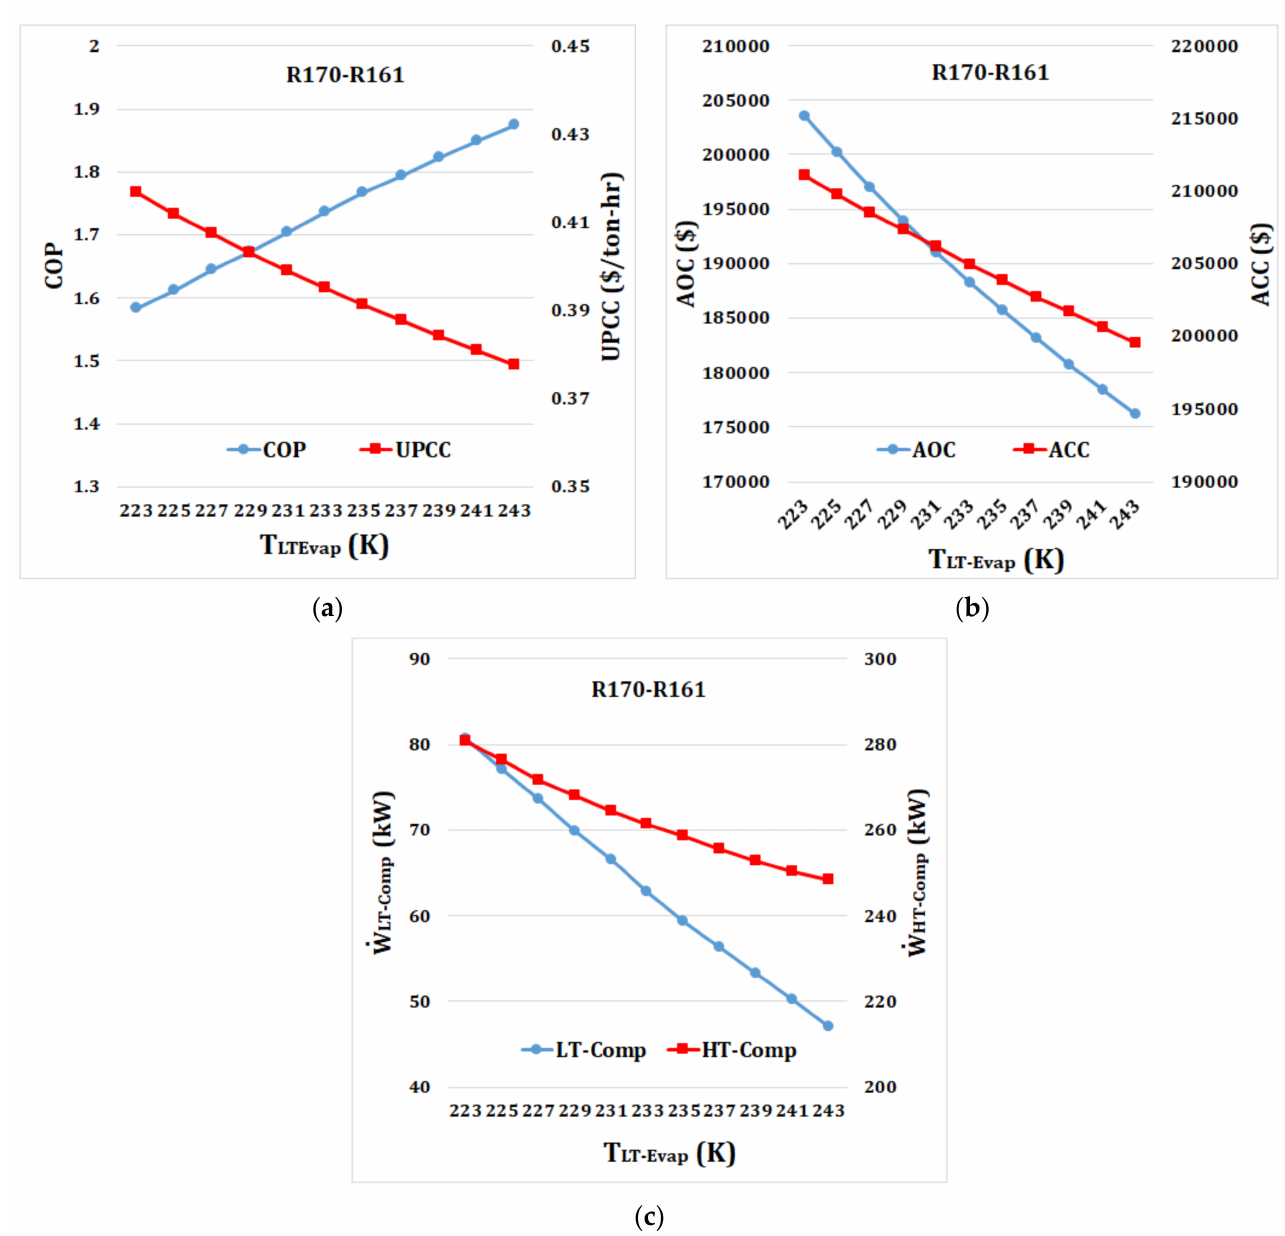
. . W LT − Comp and W HT − Comp of the optimized